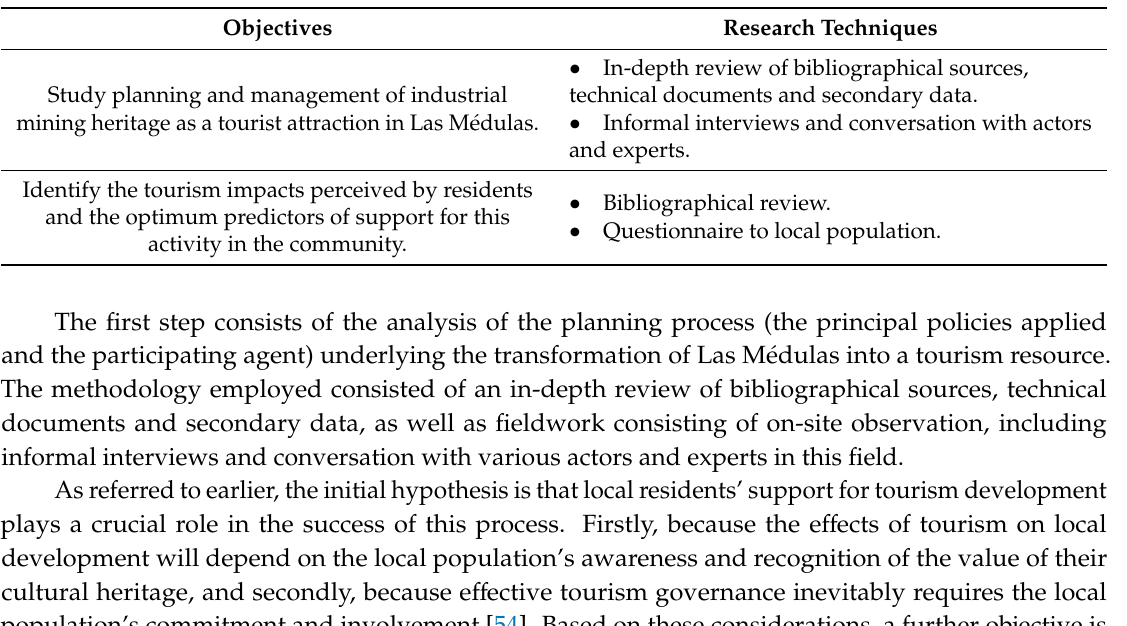
Table 1. Methodological research process Source: Author’s